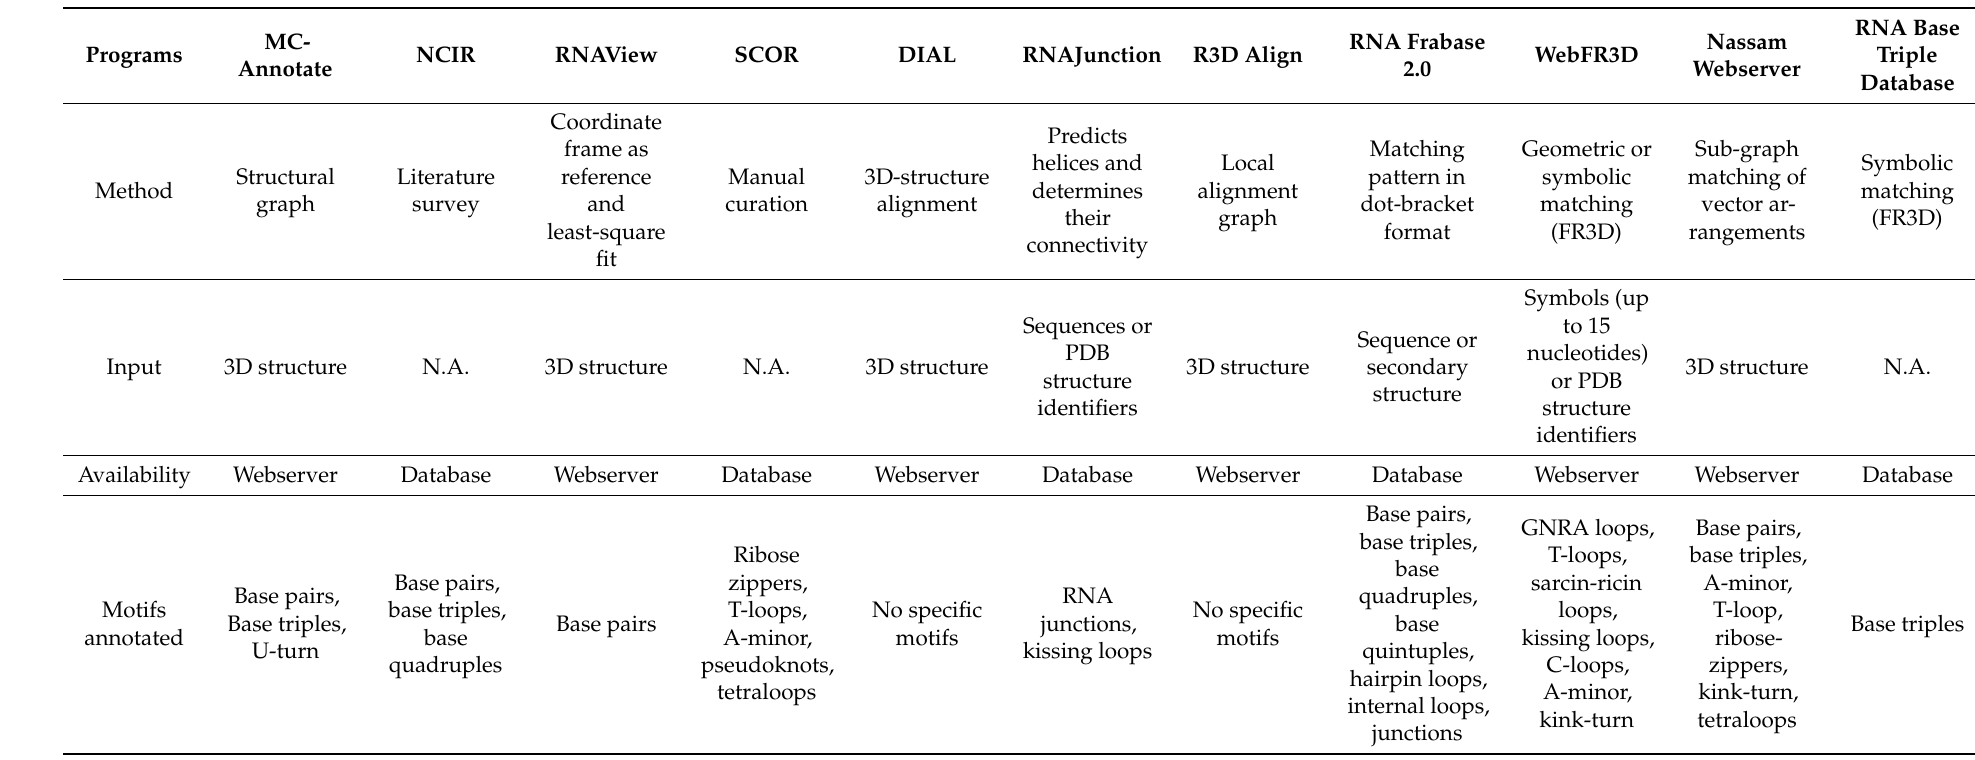
Table 1. Comparison of programs that annotate RNA base motifs in terms of the methods employed, inputs, availability, and motifs